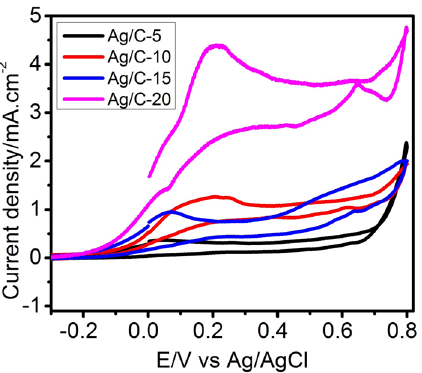
Fig. 7 CV of all Ag/C at 0.5 M NaOH + 0.01 M NaBH scan rate at 25 °C